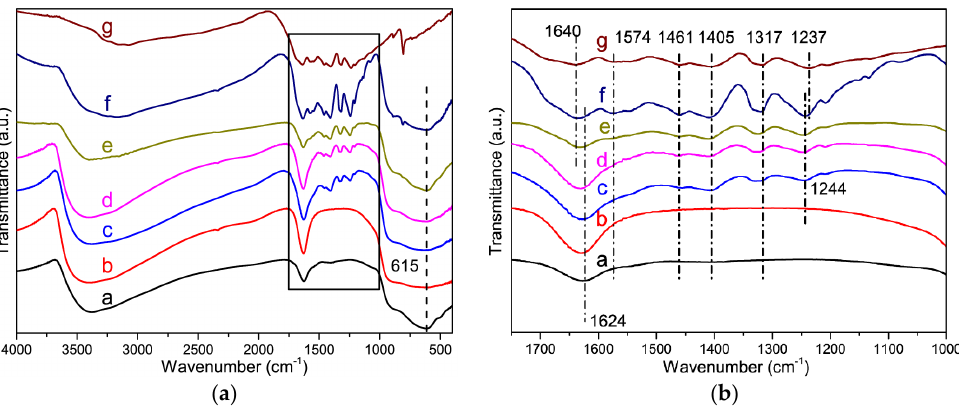
Figure 2. ( a ) FT-IR spectra of mNb 2 O 5 , g-C 3 N 4 and g-C 3 N 4 -mNb 2 O 5 composites with different contents of g-C 3 N 4 . (a, mNb 2 O 5 ; b, 1% g-C 3 N 4 -mNb 2 O 5 ; c, 4% g-C 3 N 4 -mNb 2 O 5 ; d, 10% g-C 3 N 4 -mNb 2 O 5 ; e, 20% g-C 3 N 4 -mNb 2 O 5 ; f, 50% g-C 3 N 4 -mNb 2 O 5 ; g, g-C 3 N 4 ); and ( b ) enlarged FT-IR spectra corresponding to rectangle region from ( a ).